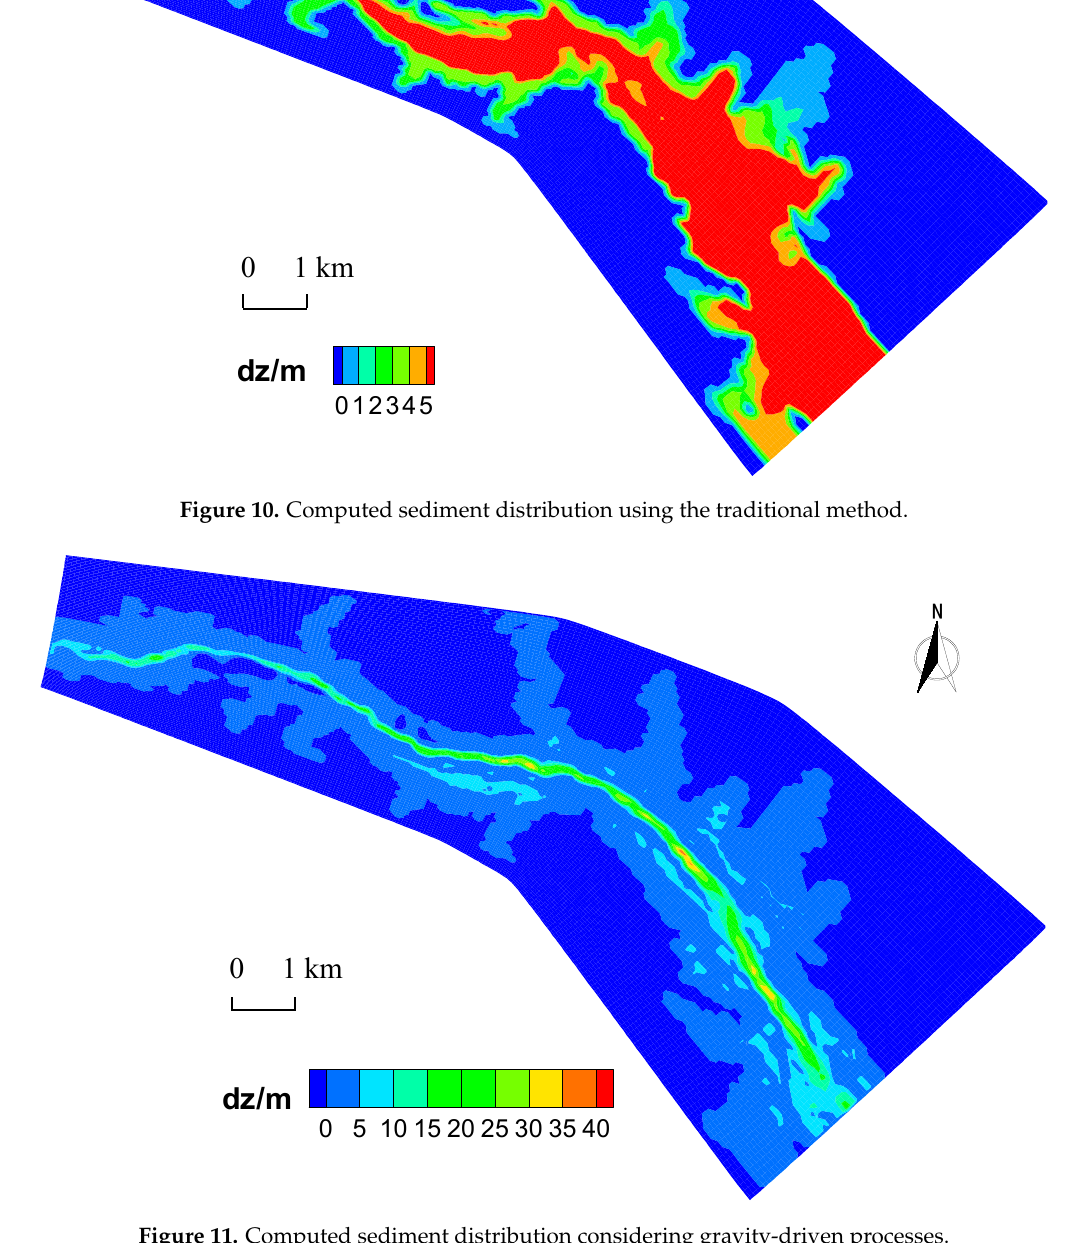
Figure 11. Computed sediment distribution considering gravity-driven processes.